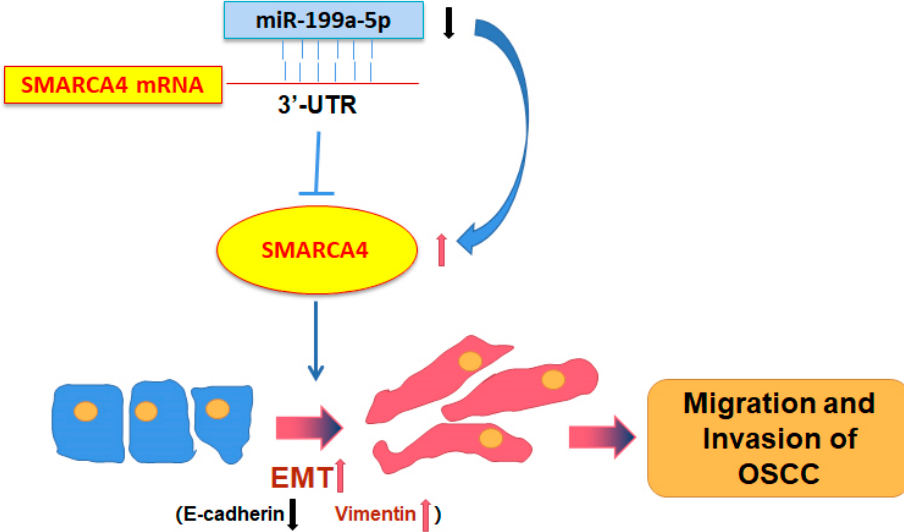
Figure 9. The proposed model for SMARCA4-promoted metastasis in OSCC. The miR-199a-5p -SMARCA4 axis regulates OSCC cell migration and invasion through EMT and plays a critical role in OSCC